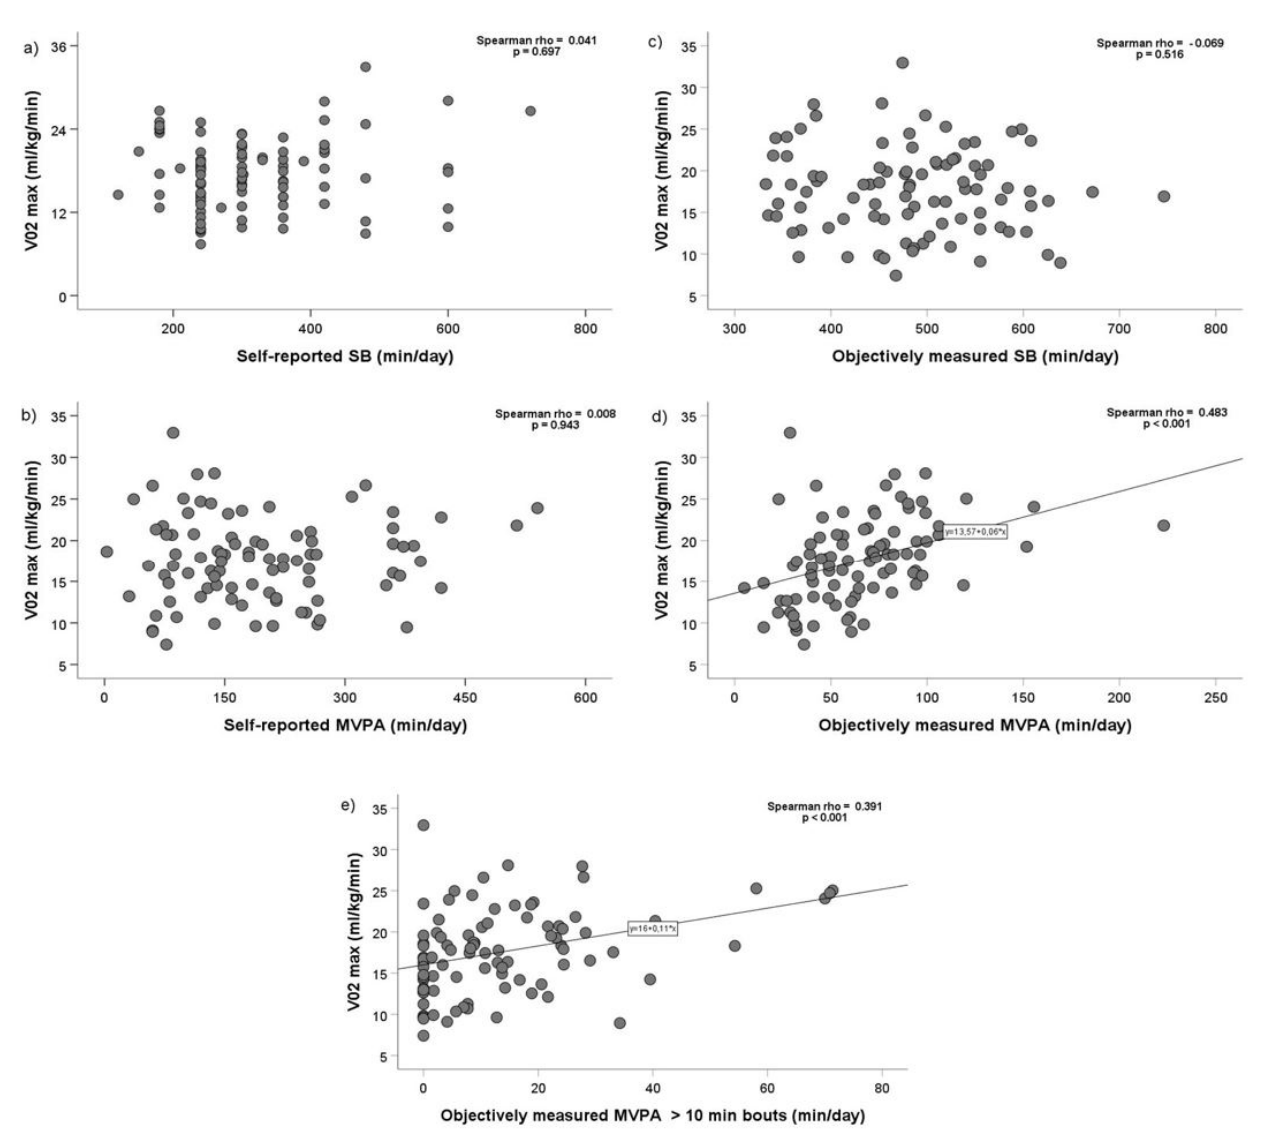
Figure 2. Correlations between maximal aerobic capacity, physical activity, sedentary behavior assessed by the IPAQ-SF (self-reported measure) ( a , b ), and accelerometry (objective measure) ( c – e ). VO 2 max—maximal aerobic capacity; SB—sedentary behavior; MVPA—moderate to vigorous physical activity; IPAQ-SF—international physical activity questionnaire short form. Data are presented in scatter plots.